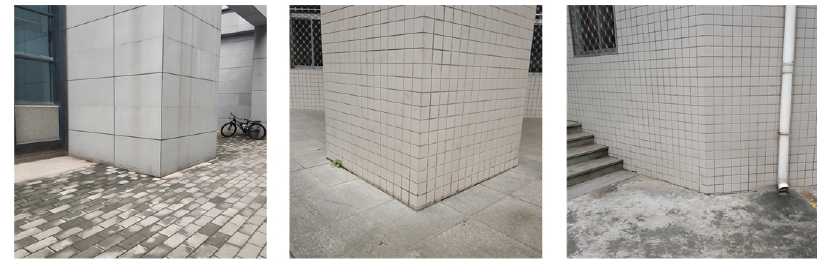
Figure 2. Some building corners in common